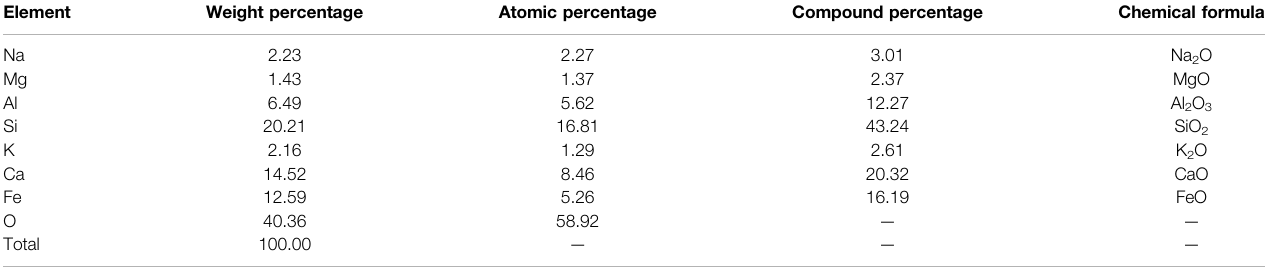
TABLE 4 | Elemental composition for selected areas in the one-part geopolymer-stabilized soil sample with 90% GGBFS and 10% FA at 4.64 mol/L NH solution for C-S-H. Element Weight percentage Atomic percentage